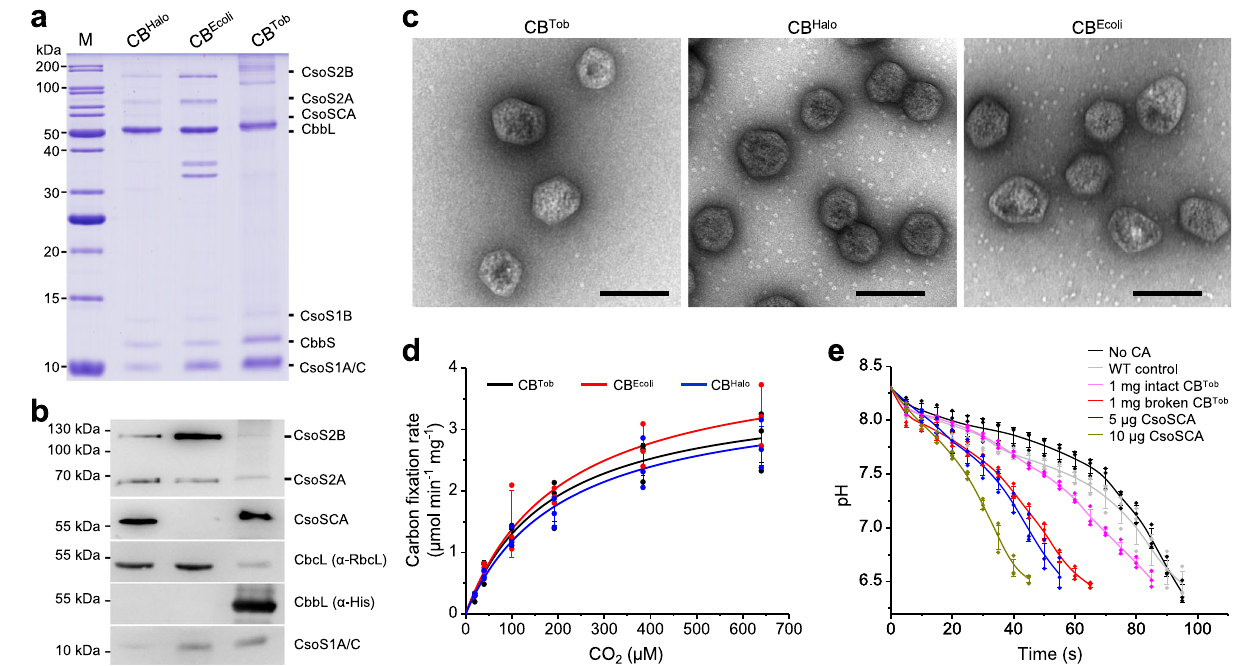
Fig. 3 | Determination of the assembly and enzymatic activity of the puri fi ed carboxysomes. a , b Representative SDS-PAGE ( a ) and immunoblot analysis ( b ) of native α -carboxysomes puri fi ed from H. neapolitanus (CB Halo ), synthetic α - carboxysomes from E. coli (CB Ecoli ) 31 , and chloroplast-expressed α -carboxysomes from tobacco (CB Tob ). At least three biologically independent samples were ana- lyzed. All the protein amounts in SDS-PAGE and immunoblot analysis are 20 µ g exceptfortheimmunoblotanalysisofCsoS2,inwhichthetotalproteinamountsof CB Halo , CB Ecoli , and CB Tob are 2 µ g, 2 µ g, and 20 µ g. c EM images of isolated carboxy- somes. The CB Tob are structurally variable, with an average diameter is 154.1±36.9nm ( n =204), which is slightly greater than those of CB Halo (~130nm) 39 and CB Ecoli (120 – 140nm) 29,31 . Scale bar: 200nm. d Carbon fi xation assays of CB Tob under different CO 2 , in comparison with CB Halo and CB Ecoli . k cat c of CB Tob , CB Halo , and CB Ecoli were 3.7±0.1 μ molmg – 1 min – 1 , 3.6±0.1 μ molmg – 1 min – 1 and